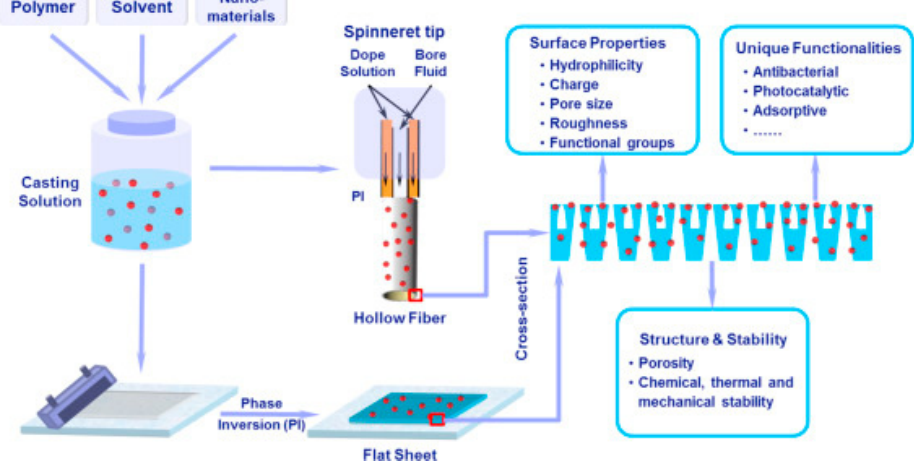
Figure 4. Nanocomposite polymer-matrix membranes for water purification